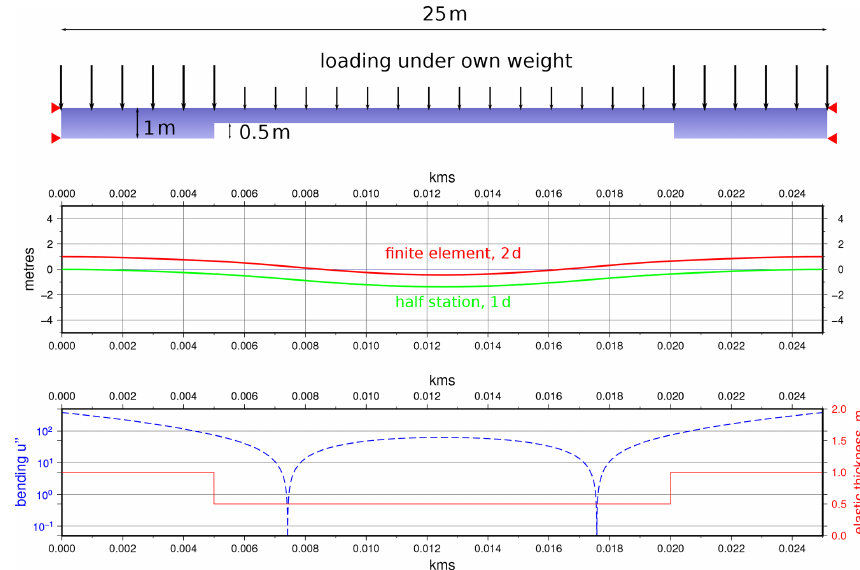
Figure C1. Comparison of a 2D linear elastic beam model with fourth-order, 1D, half-station approximation for a case with abrupt jumps in elastic thickness. The maximum difference between the two models is ∼ 3 . 5% for a case with much larger strain than lithospheric